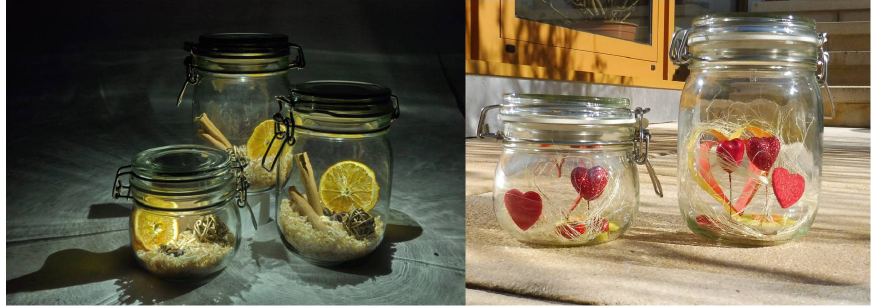
Fig. 2. Two examples of SunJar